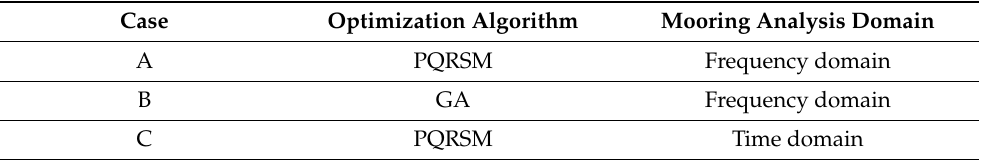
Table 4. The analysis matrix.